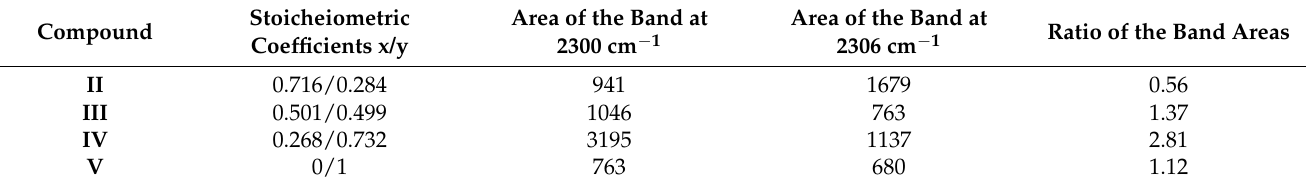
Figure 7. A detail of the Raman spectra of compounds ( II )–( V ) containing phosphite anions (region 2500–2150 cm − 1 ).